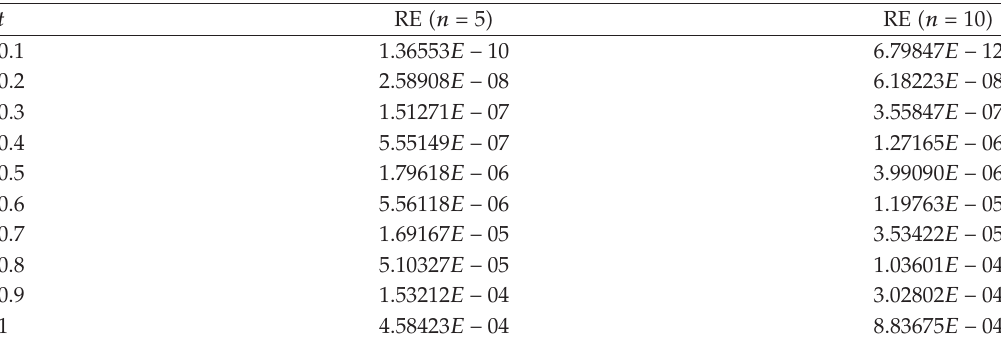
(cid:3) t (cid:4) , for Example 50